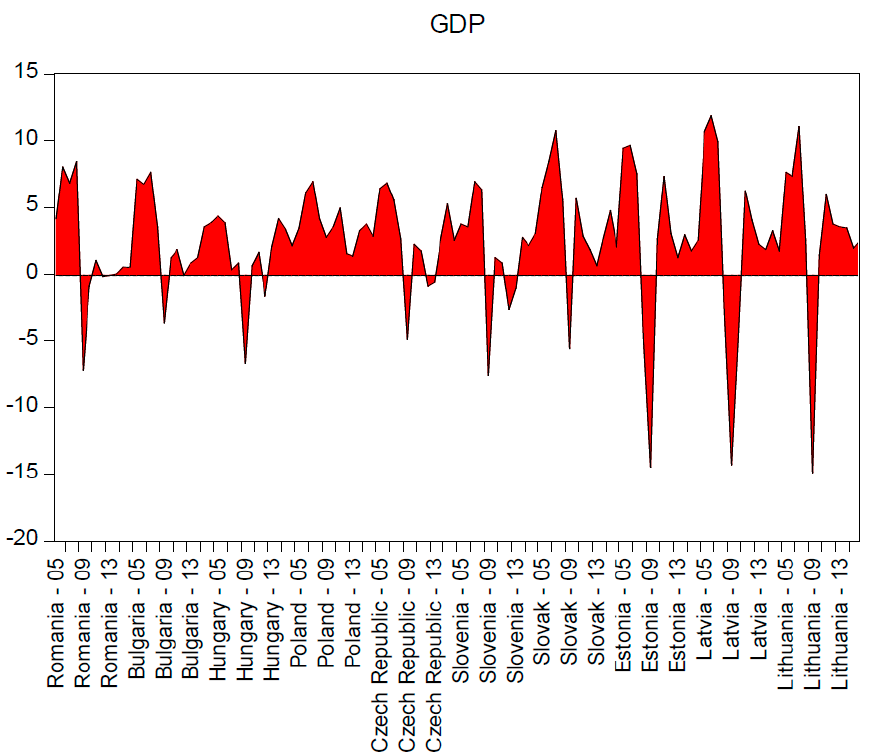
Figure 1. Gross domestic product (GDP) annual percentage change in Central and Eastern European (CEE) countries.